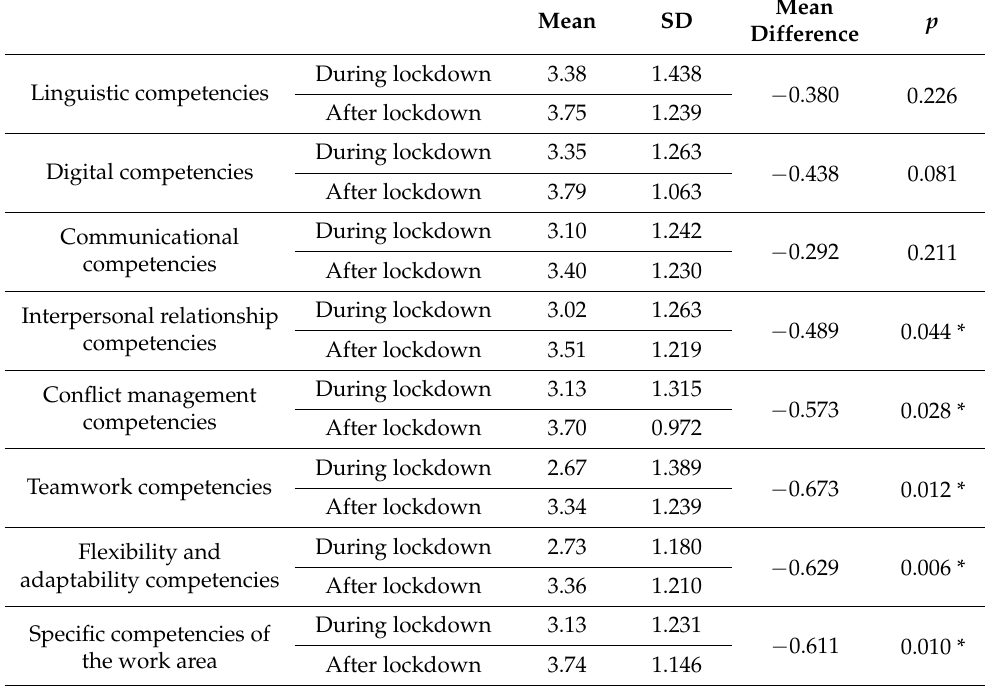
Table 3. Perceived need to improve competencies—comparison: during and after